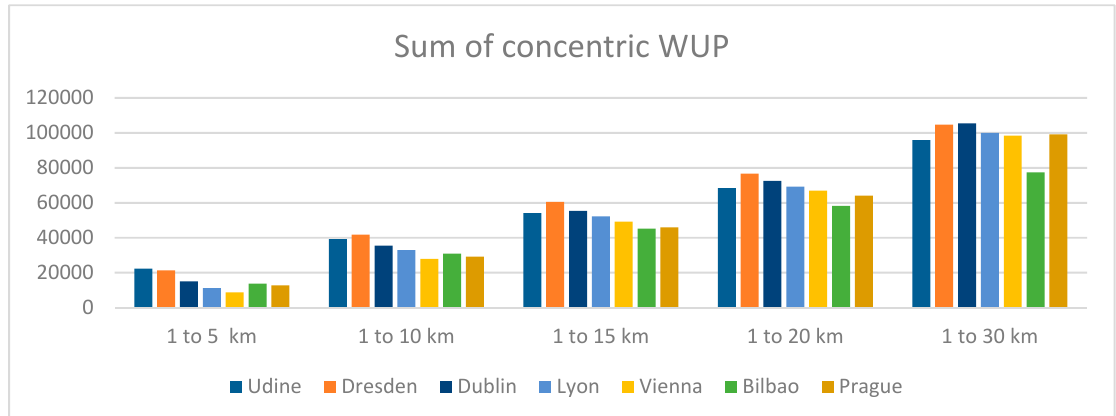
Figure 9. Average of average WUP aggregated for concentric rings ranging from 1 to 5 km distance to 1 to 30 km distance and 1 to city’s edge. Cities are listed in order of sprawl based on the European Environment Agency and European Commission’s Joint Research Centre’s 2006 report.